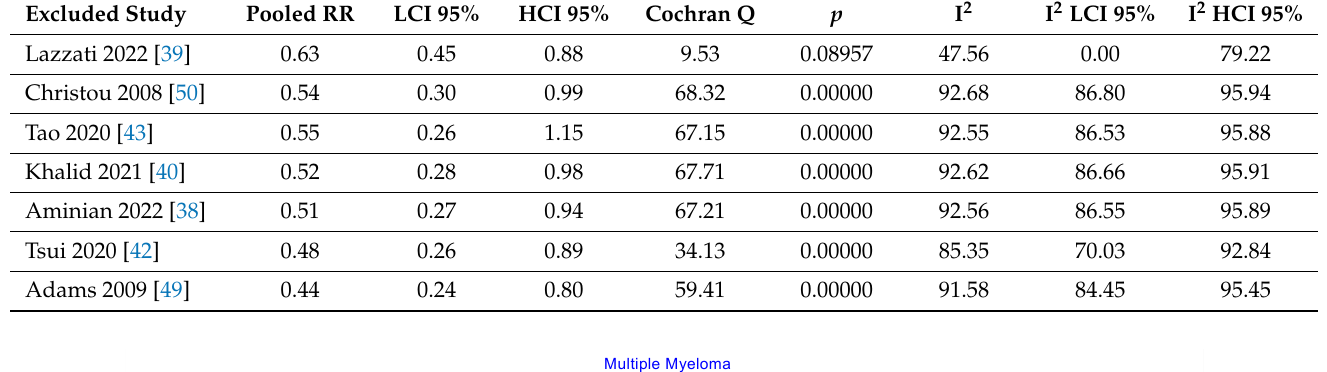
Table A16. Pancreatic cancer random effects model sensitivity analysis.